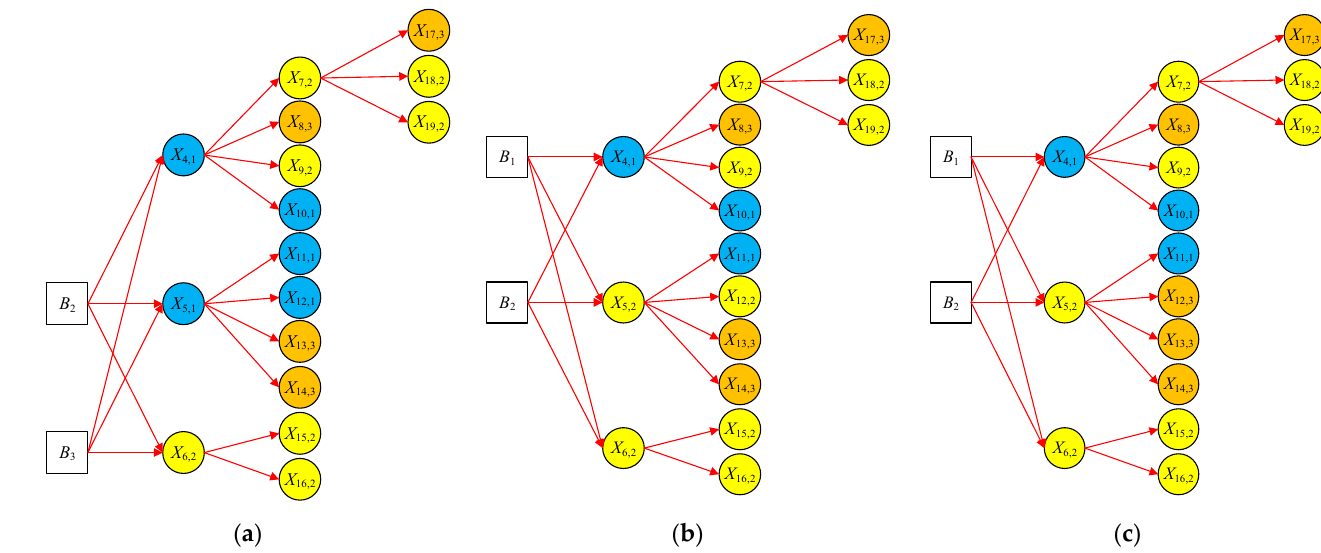
Figure 12. Subgraphs of X 12 in different states with E 5 , listed as ( a ) DUCG 1 , ( b ) DUCG 2 , and ( c ) DUCG 3 .